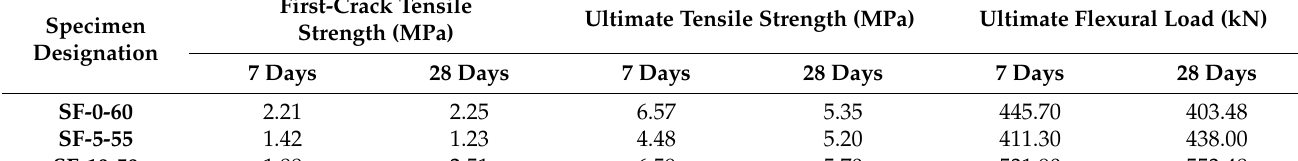
Table 4. Mechanical properties of slag/fly-ash-based ECCs.